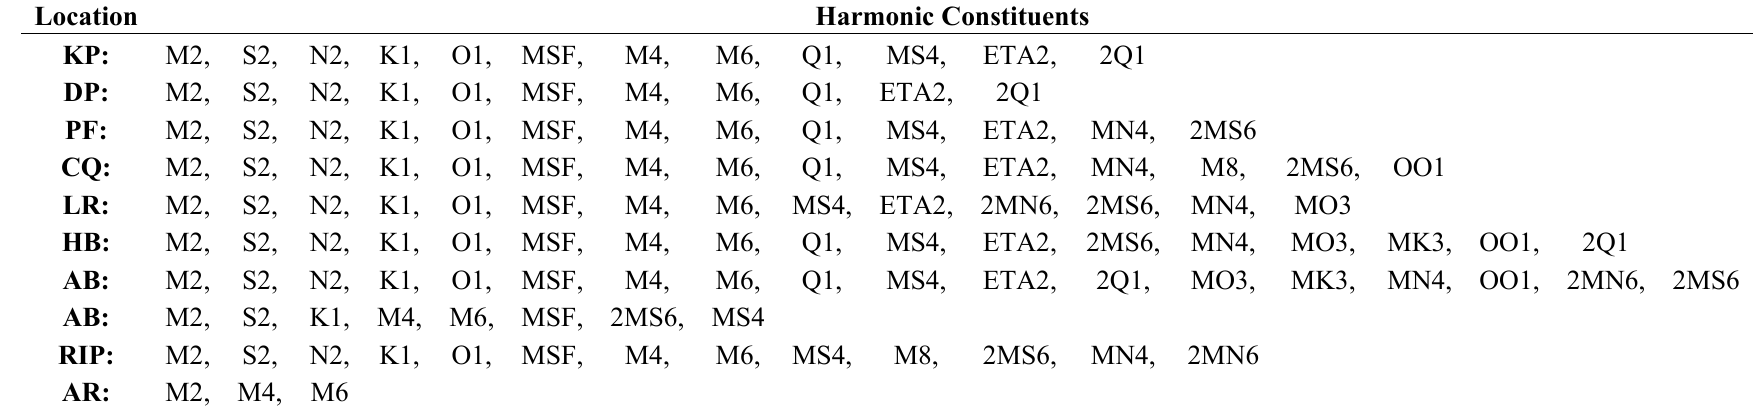
Table 2. List of harmonic constituents used in predicting surface elevation at Killard Point (KP), Dogtail Point (DP), Portaferry Quay (PQ), Catherines Quay (CQ), Limestone Rock (LR), Home Bay (HB), AFBI Buoy (AB) and in predicting current velocity at AFBI Buoy (AB), Round Island Pinnacle (RIP) and Artificial Reef (AR). Location Harmonic Constituents